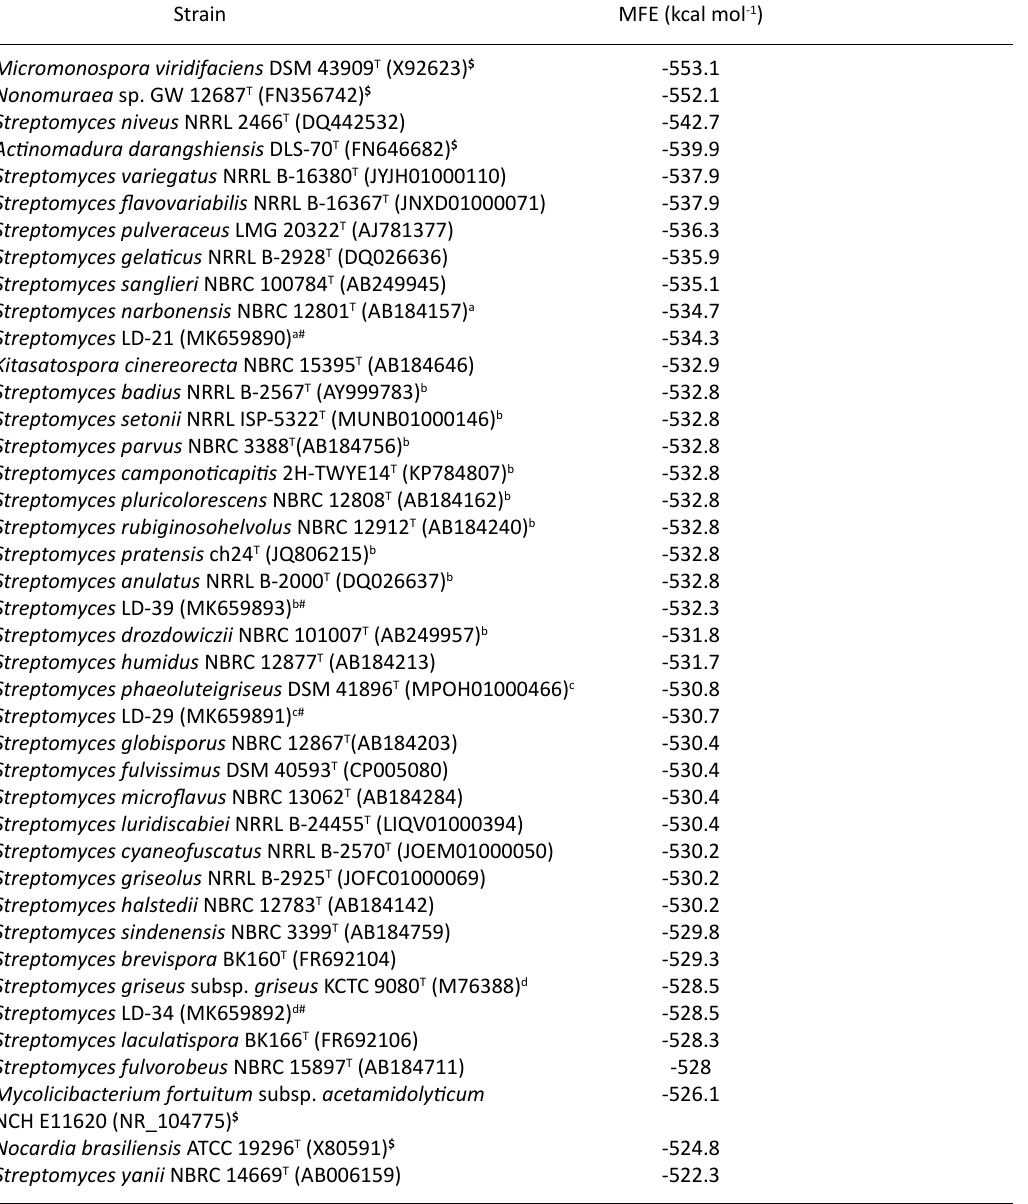
Table 3. Minimum free energy (MFE) in kcal mol -1 of the predicted 16S rRNA secondary structures of the bioactive isolates along with thirty-two related type strains from EzBioCloud database. Five outgroups have also been included for comparison. The MFEs have been arranged in ascending order